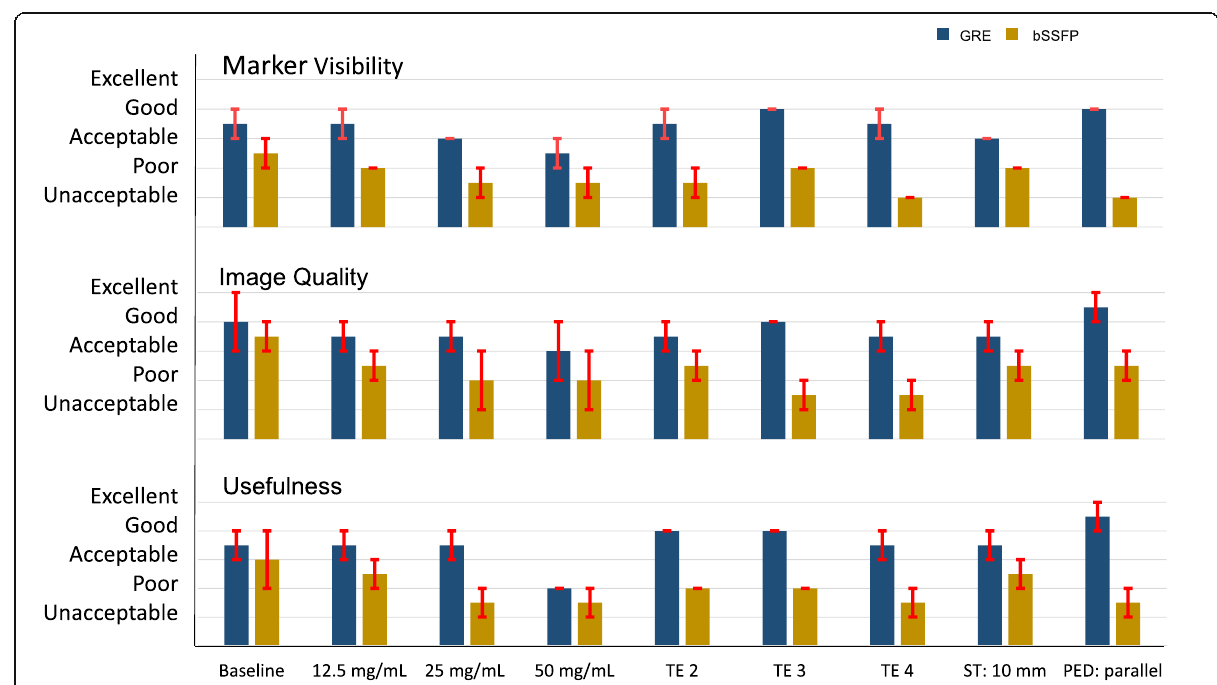
Fig. 6 Median (blue and yellow bars) and individual observer (red bars) scores for marker visibility, image quality and usefulness of balanced steady-state free precession (bSSFP), and gradient echo (GRE) scans for the evaluated parameters: marker concentration, echo time (TE), slice thickness (ST), and phase encoding direction